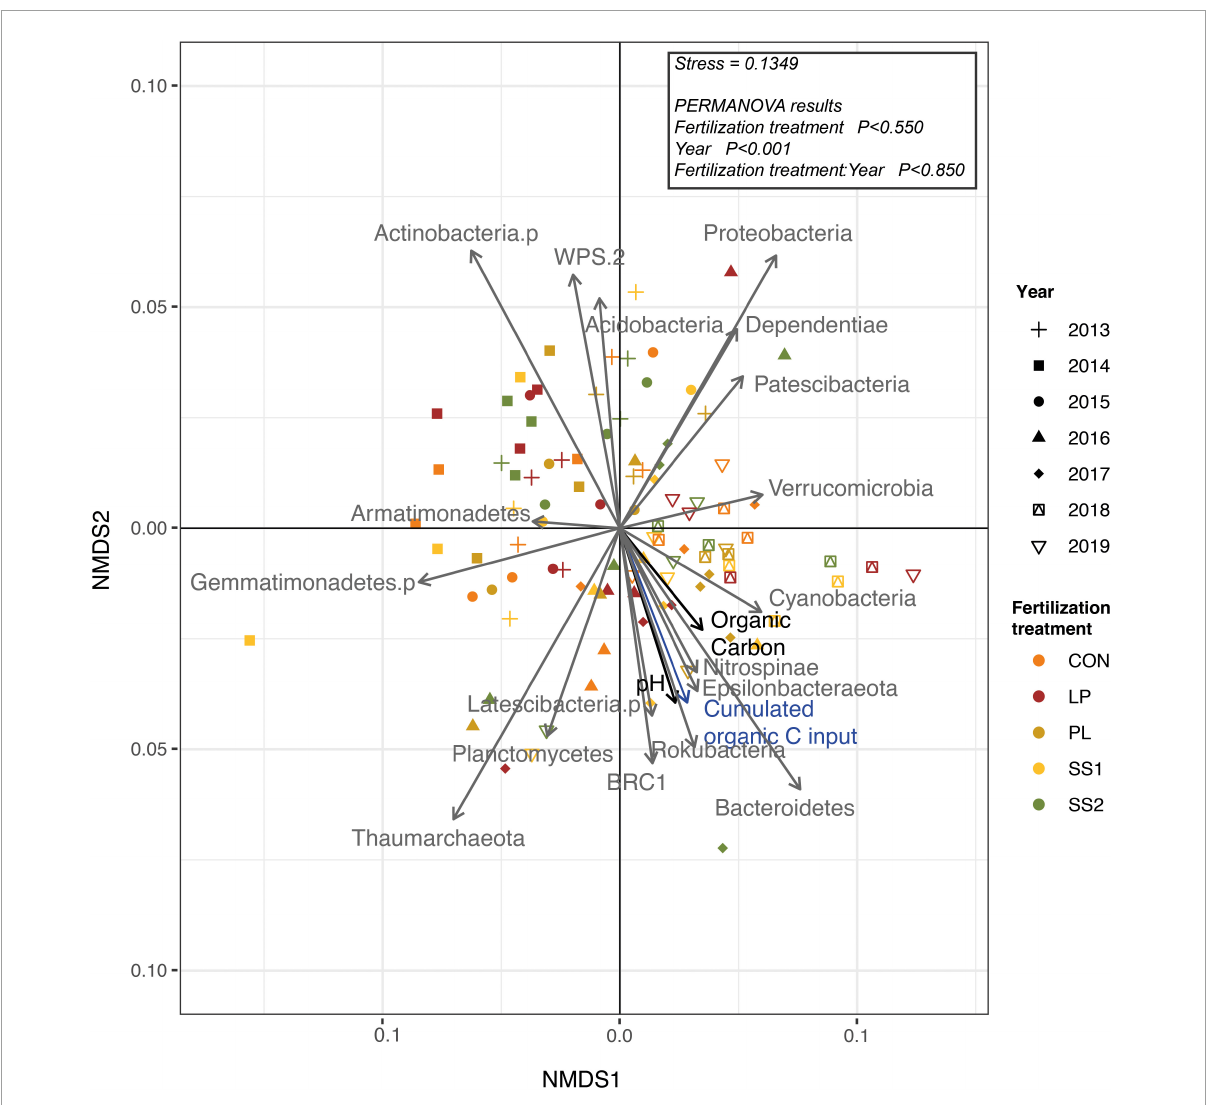
FIGURE4 Non-metric Multi-Dimensional Scaling (NMDS) ordination plot derived from Bray Curtis dissimilarity distances for the bacterial and archaeal community in soil from La Mare (Reunion Island) fertilized or not (CON, inorganic fertilizer control) with four different organic materials (SS1 and SS2, sewage sludge inputs; LP, liquid pig manure; PL, poultry